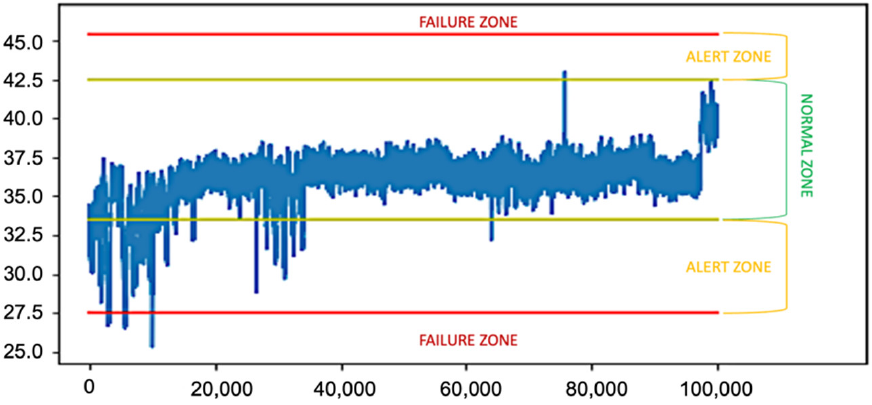
Figure 3. Normal, alert, and failures zones for the variable Temperature.